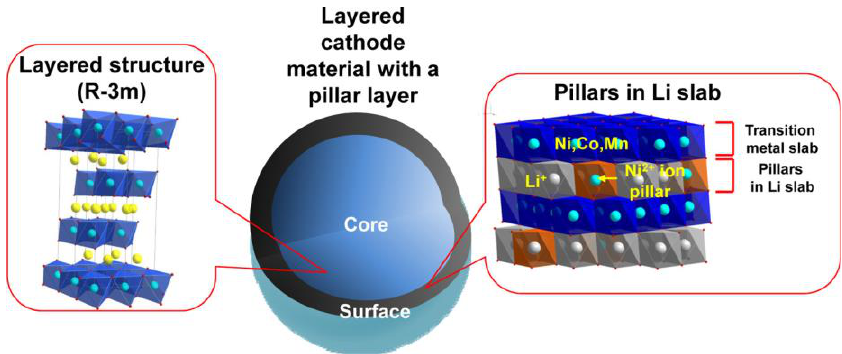
Figure 1. Schematic view of the layered NCM crystal structure